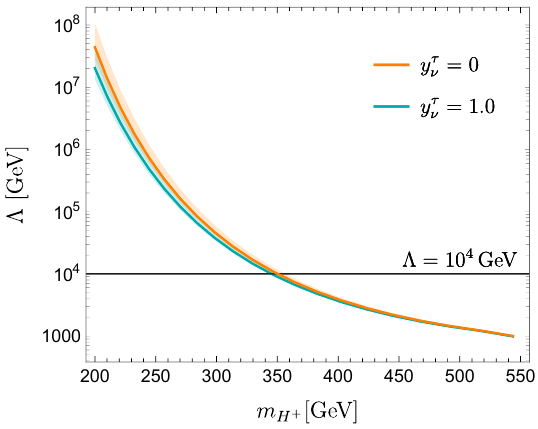
= 0 (orange) and y τ = 1 . 0 ν ν